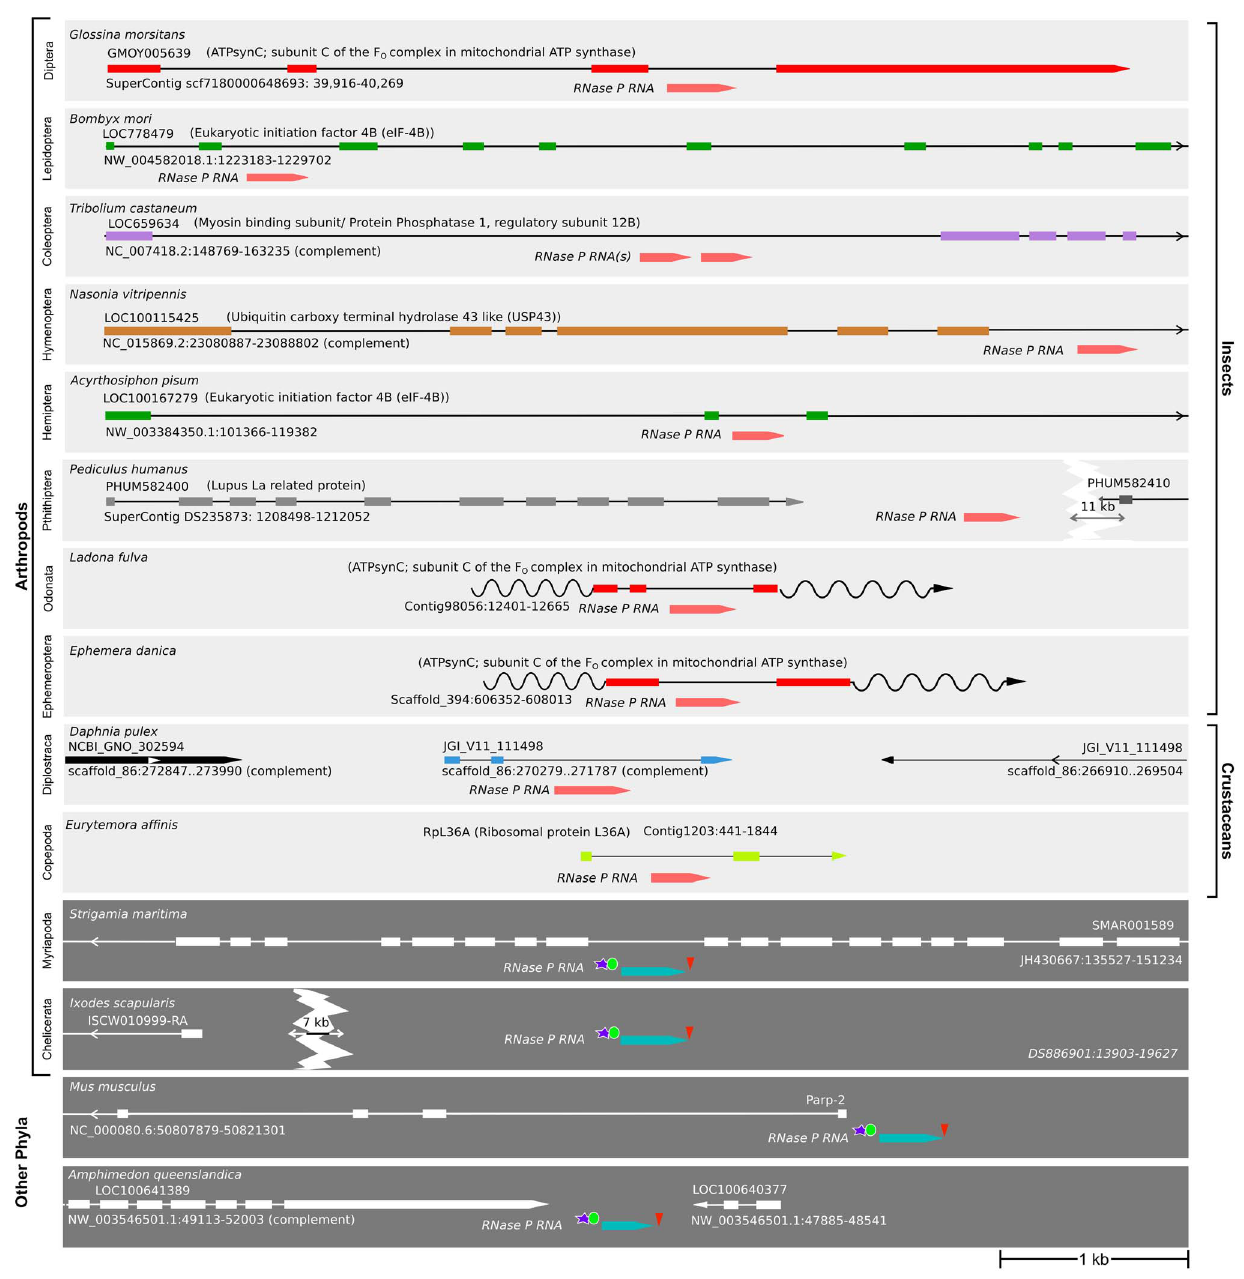
Fig. 4. Insects and crustaceans have RPR genes embedded in polII recipient genes, while other animals have independent polIII genes. The location of RPR and the neighboring genes in representative species of insects, crustaceans, and other animals are shown. In insects and crustaceans (light grey), RPR genes lack pol III signals and are in an intron (see also S2 Fig.). The P. humanus gene lacks pol III signals and is currently annotated between two genes. Each recipient gene is color-coded (as in Fig. 5; homologous genes have the same color). In other sub-phyla of Arthropoda (Myriapoda and Chelicerata) and other phyla (Deuterostomia and Porifera) (dark grey), RPR is an independent pol III-regulated gene (see also S2 Fig.). RPRs without pol III signals, pink; RPRs with pol III signals, blue; proximal sequence element (PSE), blue star; TATA box 21–27 nucleotides upstream of RPR, green oval; 3 9 poly-T stretch of 4–5 nucleotides, red triangle. Wavy lines indicate regions where either poor sequence quality or weak homology prevents accurate prediction of the exons. Scale bar is 1